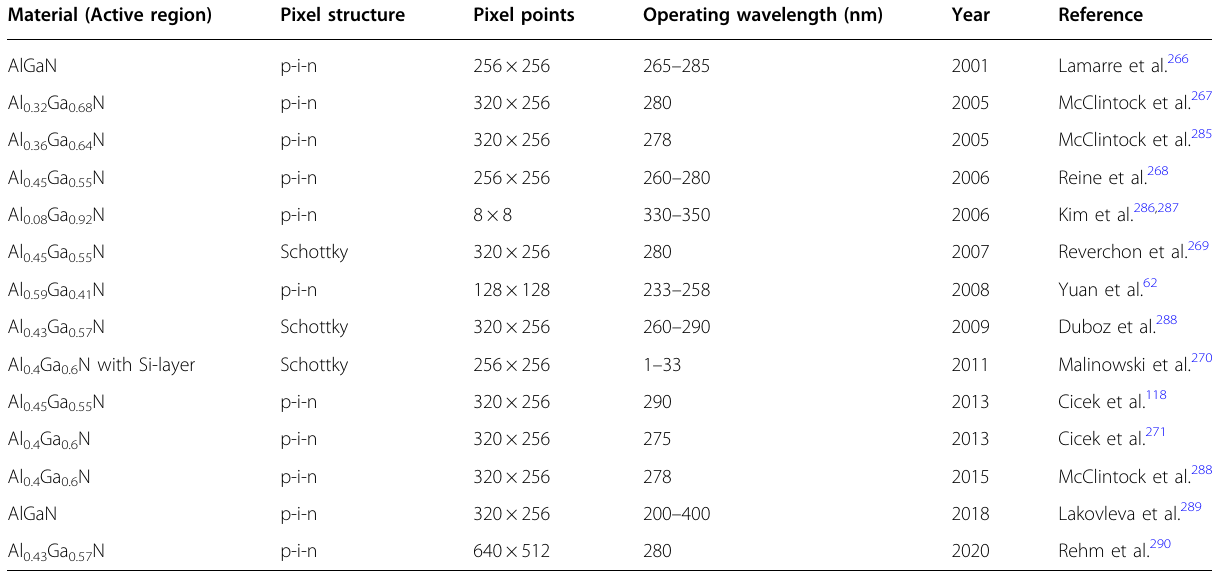
Table 4 Summary of reported AlGaN-based focal plane arrays Material (Active